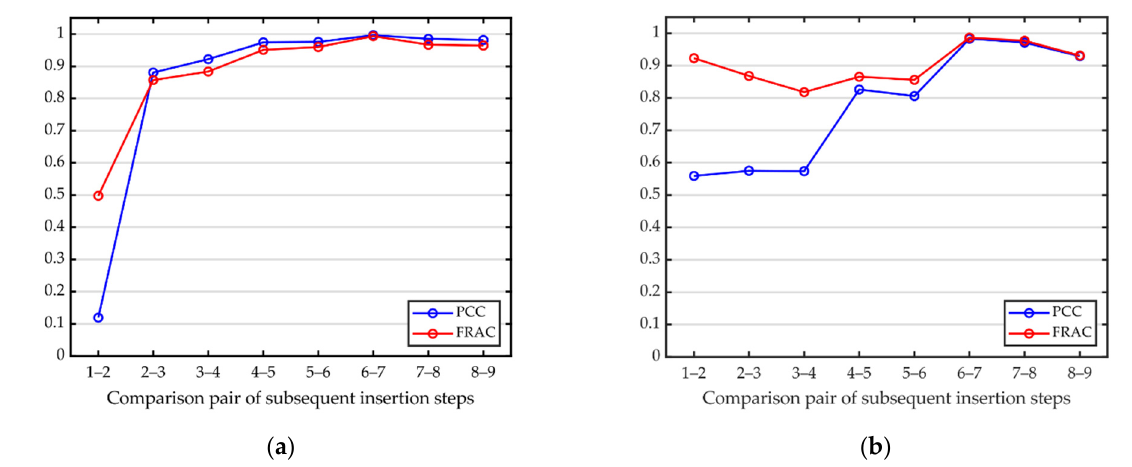
Figure 8. Comparison of FRFs corresponding to subsequent insertion steps with soft tissue in the ML direction.